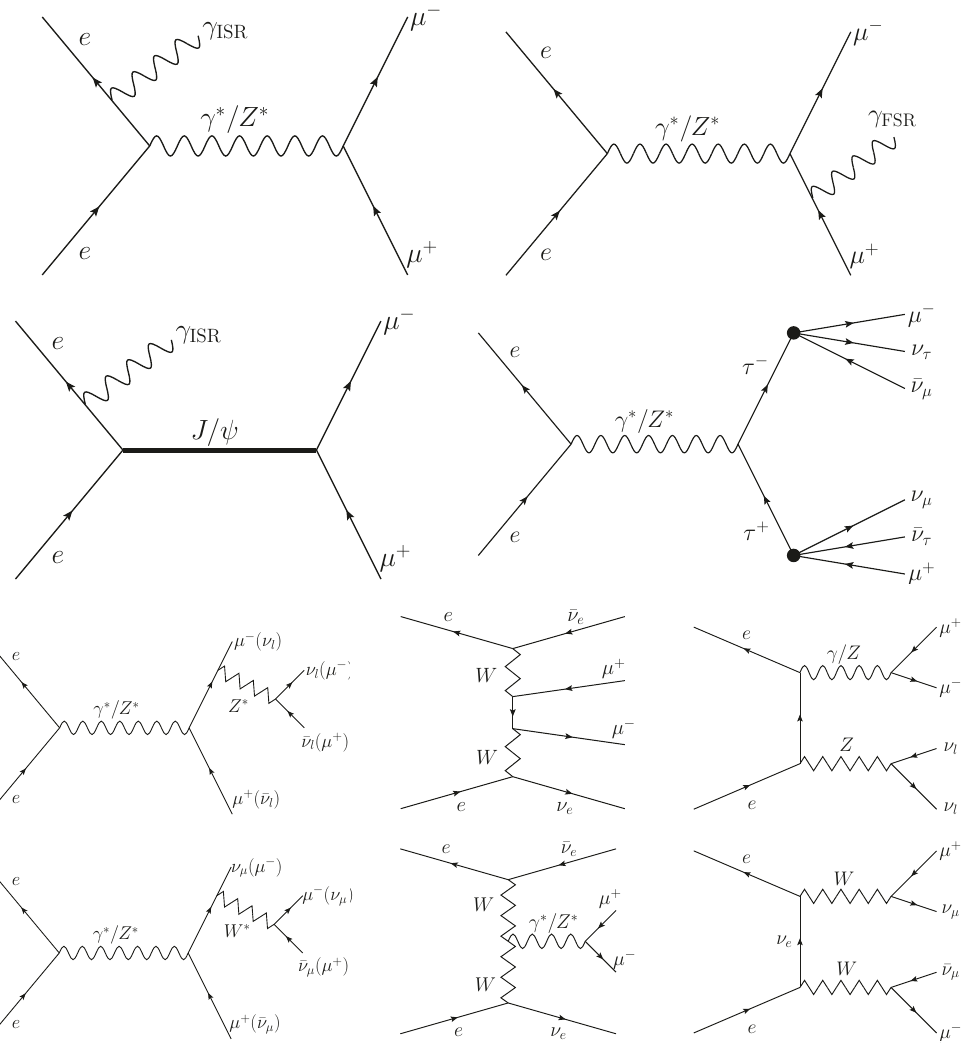
Figure 5 . Main backgrounds from i) (cid:22) (cid:0) (cid:22) + (cid:13) ISR ; FSR (top), ii) (cid:22) (cid:0) (cid:22) + (cid:13) ISR via J= meson production (middle left), iii) (cid:28) (cid:0) (cid:28) + ( (cid:22) (cid:0) (cid:22) + (cid:23) (cid:22) (cid:23) (cid:28) (cid:22) (cid:23) (cid:22) (cid:22) (cid:23) (cid:28) ) (middle right), and iv) W - and Z - involved process !